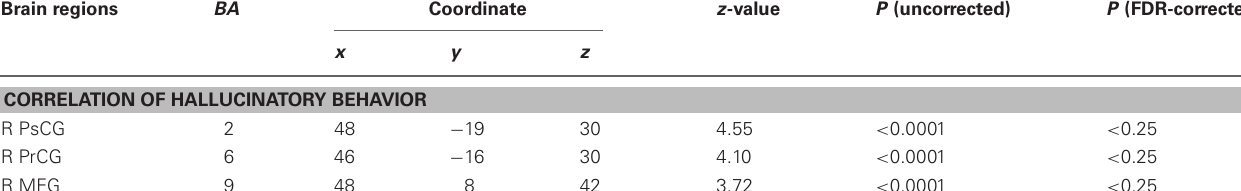
Table 5 | Positive correlation between the severity of hallucinatory behavior and cerebral activation under FJT minus GDT, p < 0 . 0001 uncorrected ( p < 0 . 25, FDR-corrected), R, right hemisphere. Brain